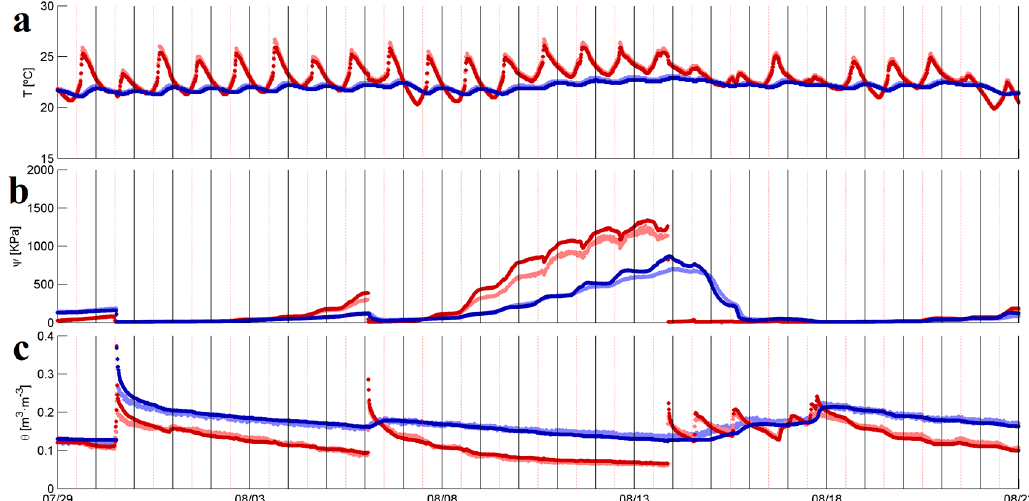
Figure 7. Comparison of ( a ) soil temperature, T in Celsius degrees; ( b ) matric water potential (WP), ψ in kPa; and ( c ) volumetric soil moisture (SM), θ in m 3 · m − 3 data collected by a data logger (DL2) and wireless nodes (2282 and 2292) from the ASWP network between 29 July and 23 August 2016. The variable at a depth of 10 cm is shown in dark red for the data logger and light red for the nodes. The variable at a depth of 30 cm is shown in dark blue for the data logger and in light blue for the nodes.